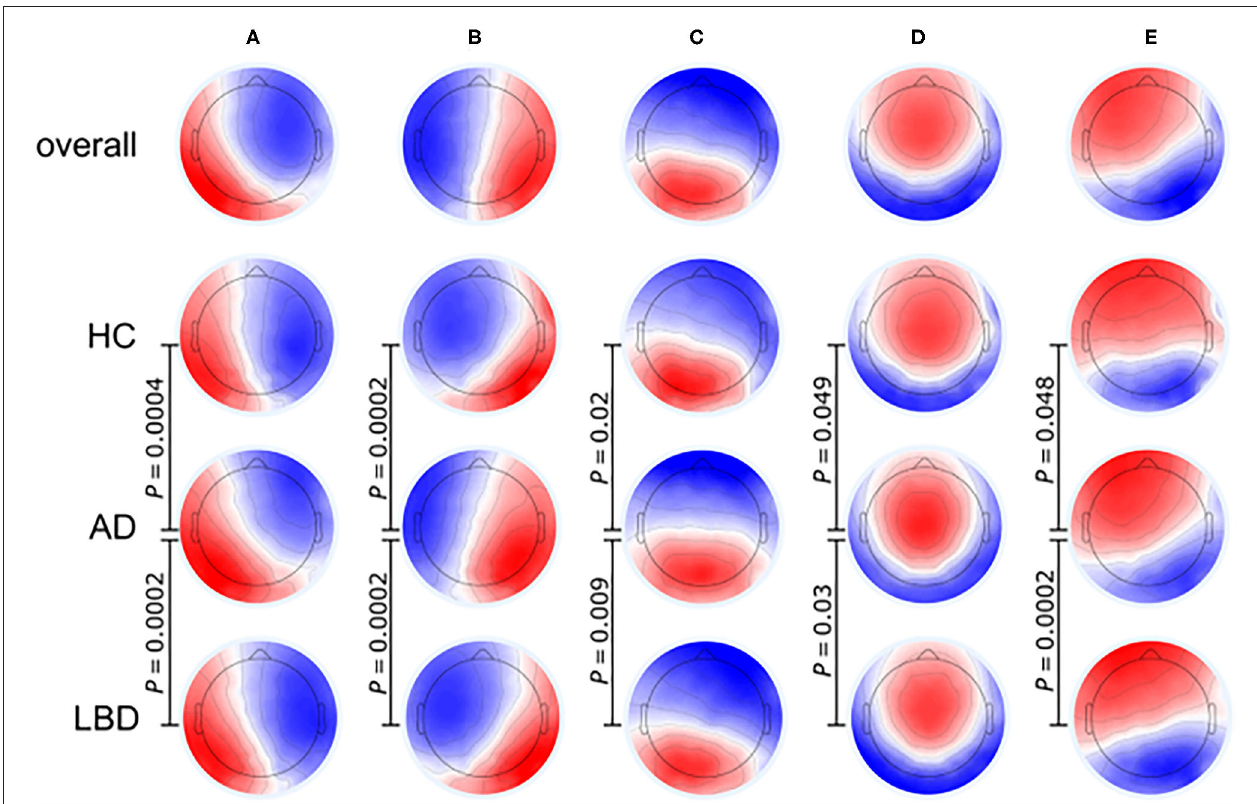
FIGURE 4 | Microstate class topographies for dynamic brain activities in Alzheimer’s disease (AD) and Lewy body dementia (LBD) patients compared to healthy control (HC) group. The EEG signal was divided into a group of short, non-overlapping and quasi-stable microstates where the microstates (A–E) were related to over 70% of changes in brain activities. P -values result from comparing the group topographies between groups using TANOVA. (Image source: Schumacher et al., 2019b: use permitted under the Creative Commons CC BY